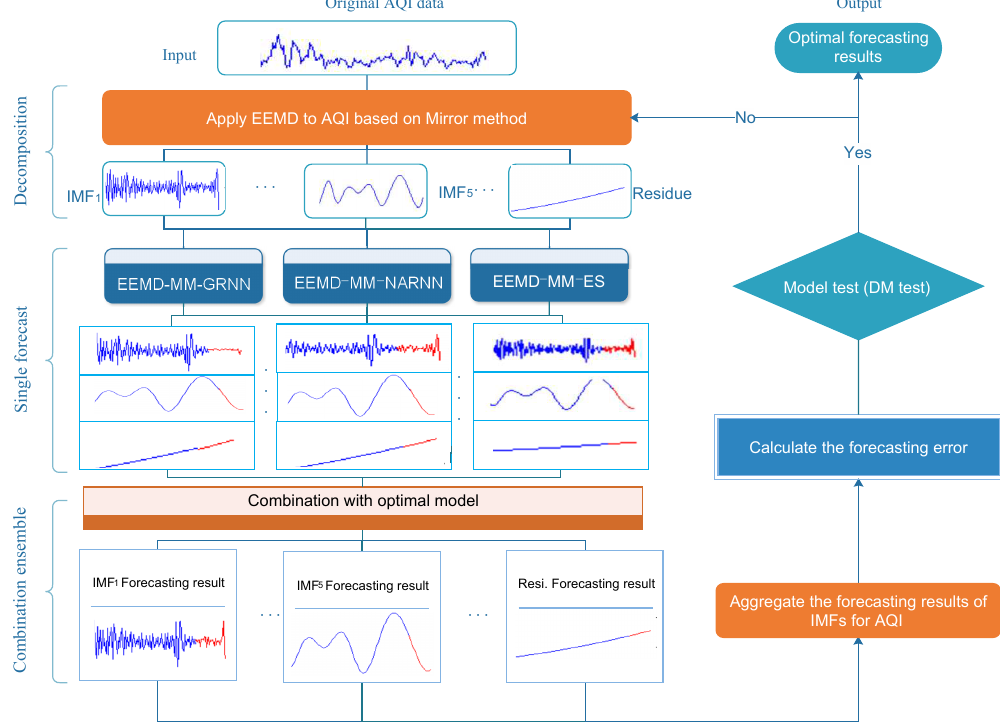
Figure 2. Framework of the proposed hybrid forecasting